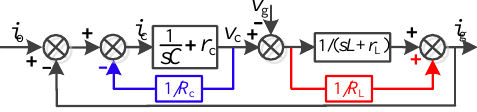
Figure 6. Block diagram of CL filter.